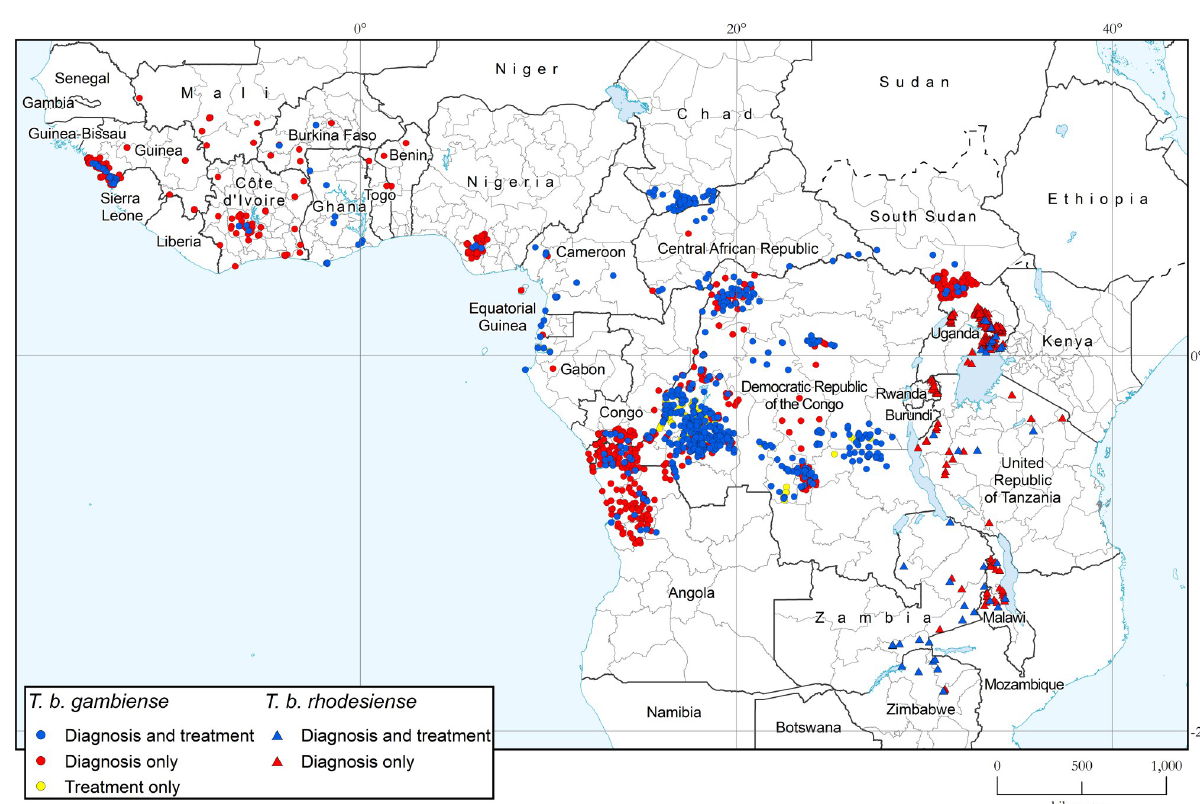
Fig 5. Geographical distribution of fixed health facilities offering diagnosis and treatment of gambiense and rhodesiense HAT. Data were collected by WHO from National Sleeping Sickness Control Programmes in June 2021. The base layers used in this map are the FAO Global Administrative Unit Layers (GAUL), Global Administrative Areas and FAO Inland water bodies in